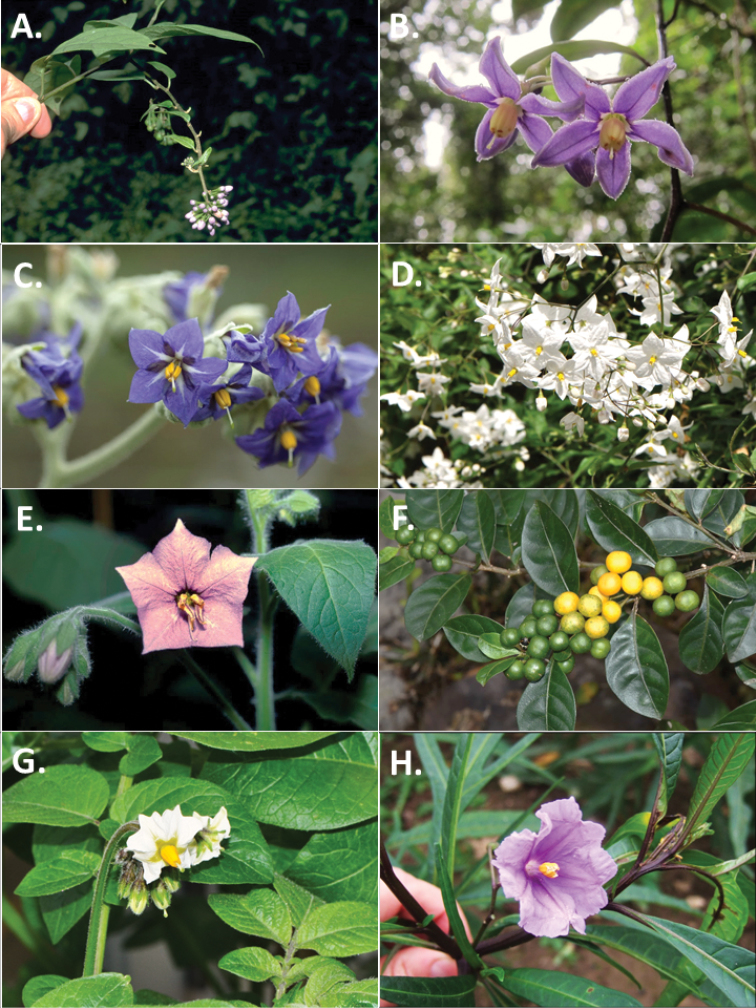
ASolanumterminale Forssk. (African non-spiny Clade) BSolanummadagascariense Dunal (African non-spiny Clade) CSolanummauritianum Scop. (Brevantherum Clade) DSolanumlaxum Spreng. (Dulcamaroid Clade) ESolanumtrisectum Dunal (Normania Clade) FSolanumdiphyllum L. (Geminata Clade) GSolanumtuberosum L. (Potato Clade) HSolanumlaciniatum Aiton (Archaeosolanum Clade). Photos A, C, D, E, F, G, H by S. Knapp B by M.S. Vorontsova.